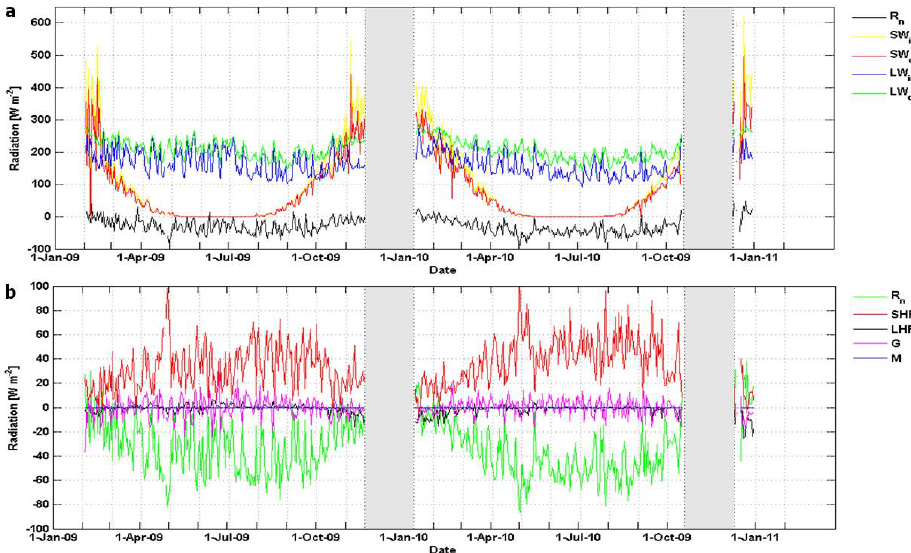
Fig. 5. Daily mean (a) net radiation R n and its components (Wm − 2 ), and (b) surface energy balance components (Wm − 2 ), 2009–2010, at AWS 16. Abbreviations stand for incoming (outgoing) shortwave (longwave) radiation (SW in , SW out , LW in , LW out , respectively), sensible